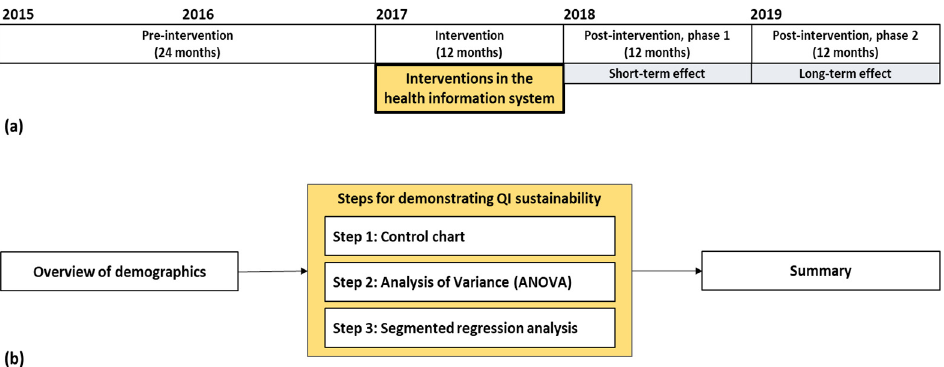
Figure 1. Study periods and steps for data analysis: ( a ) study timeline, including a 24-month pre- ber 2019) periods. The interventions were performed within 12 months (January 2017–December 2017); ( b ) steps for describing results. QI: quality improvement.